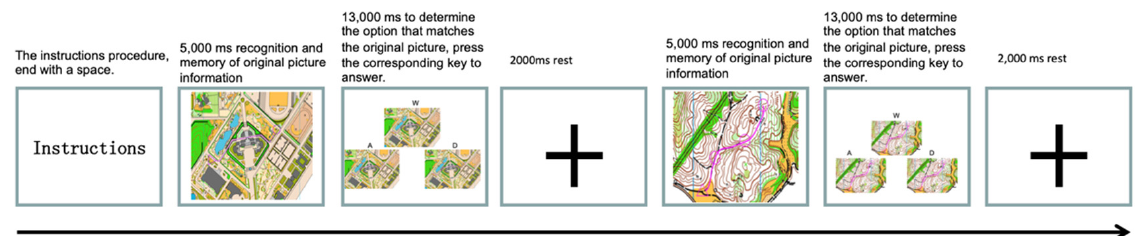
Figure 4. Experimental flow chart of the spatial working memory task in orienteering